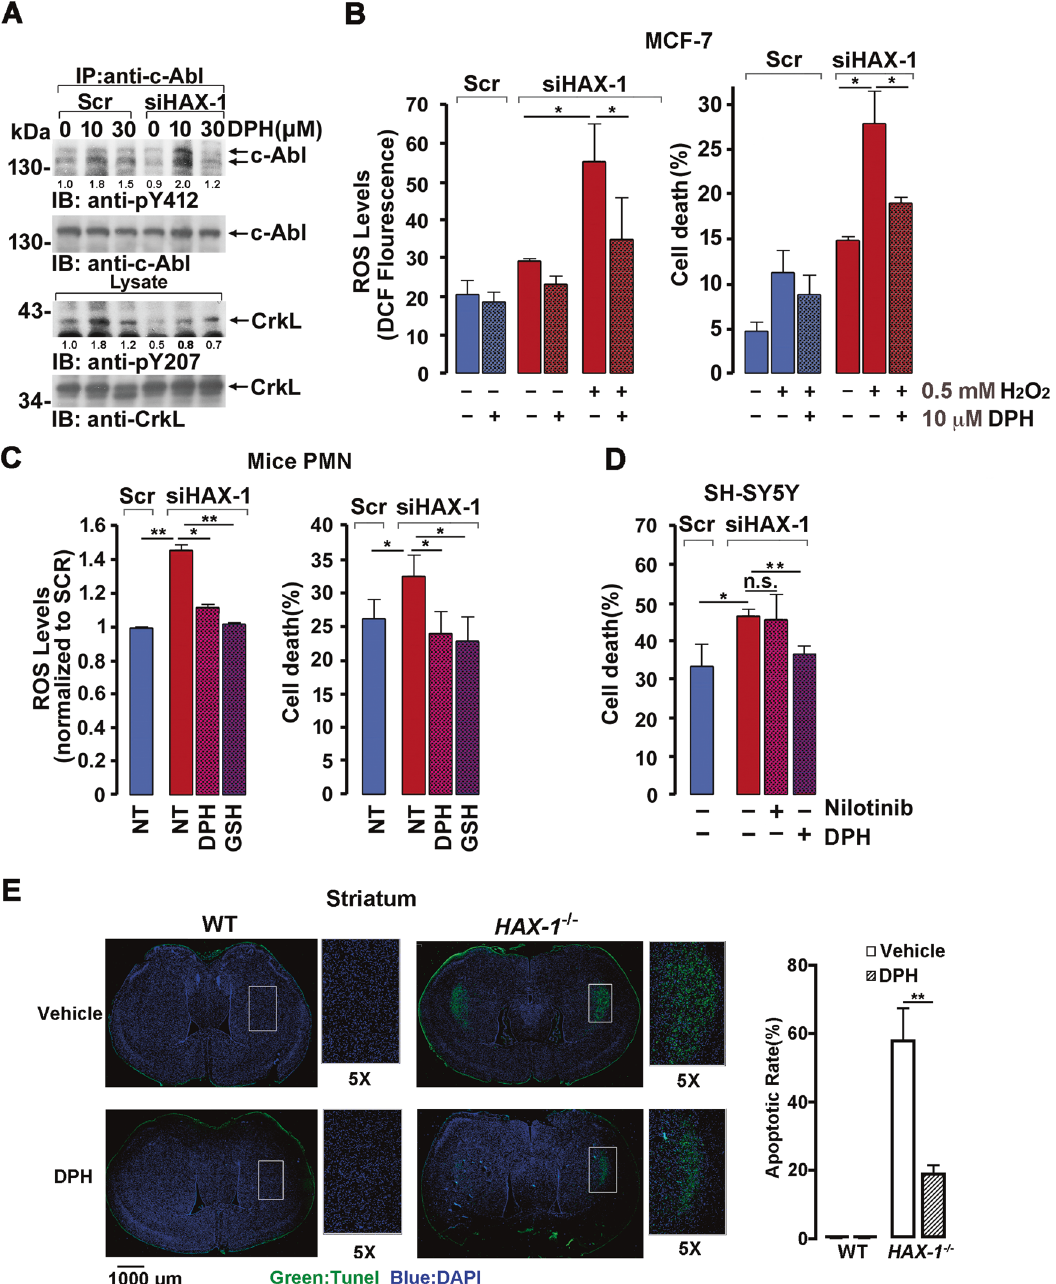
Fig. 6 c-Abl activation protected nerve cells from HAX-1 insuf fi ciency-induced ROS accumulation and death. A The MCF-7 scramble or HAX-1 knockdown cell line (MCF-7/siHAX-1) was treated with the indicated concentration of DPH for 12 h, and cell lysates were analyzed by immunoprecipitation and immunoblotted with indicated antibodies. The immunoprecipitates were normalized by c-Abl level. B MCF-7 scramble or HAX-1 knockdown cell lines (MCF-7/siHAX-1) with the indicated H 2 O 2 (3 h) or DPH (4 h) treatment were subjected to fl ow cytometry analysis to evaluate ROS levels (left panel) and ratio of cell death (right panel). n.s., not signi fi cant; * p < 0.05, Student ’ s t test. C PMN- like cells were transfected with lentivirus-HAX-1-siRNA or lentivirus-Scramble-siRNA (MOI = 5), and HAX-1 -siRNA cells were treated with DPH (10 μ M, 12 h) or GSH (1 mM, 3 h). ROS levels and ratio of cell death of all the cells were measured after exposure to 1 mM H 2 O 2 for 3 h (left panel) or for 8 h (right panel), respectively. * p < 0.05, ** p < 0.01, Student ’ s t test. D Scramble cells, siRNA- HAX-1 SY5Y cells, and siRNA- HAX-1 SY5Y cells treated with nilotinib (5 μ M, 18 h) or DPH (10 μ M, 18 h) were subjected to 0.5 mM H 2 O 2 treatment for 2 h, and the death rate was analyzed. n.s., not signi fi cant; * p < 0.05, ** p < 0.01, Student ’ s t test. E WT or Hax-1 null mice were tail vein injected with DPH or vehicle daily for 30 days, and the striatum were subjected to terminal deoxynucleotidyl transferase-mediated dUTP nick end labeling (TUNEL) staining. TUNEL- positive cells are marked in green, and nuclei are marked with DAPI. Right panel, quanti fi cation and statistical analysis of TUNEL-positive cells. ** p < 0.01, Student ’ s t test.